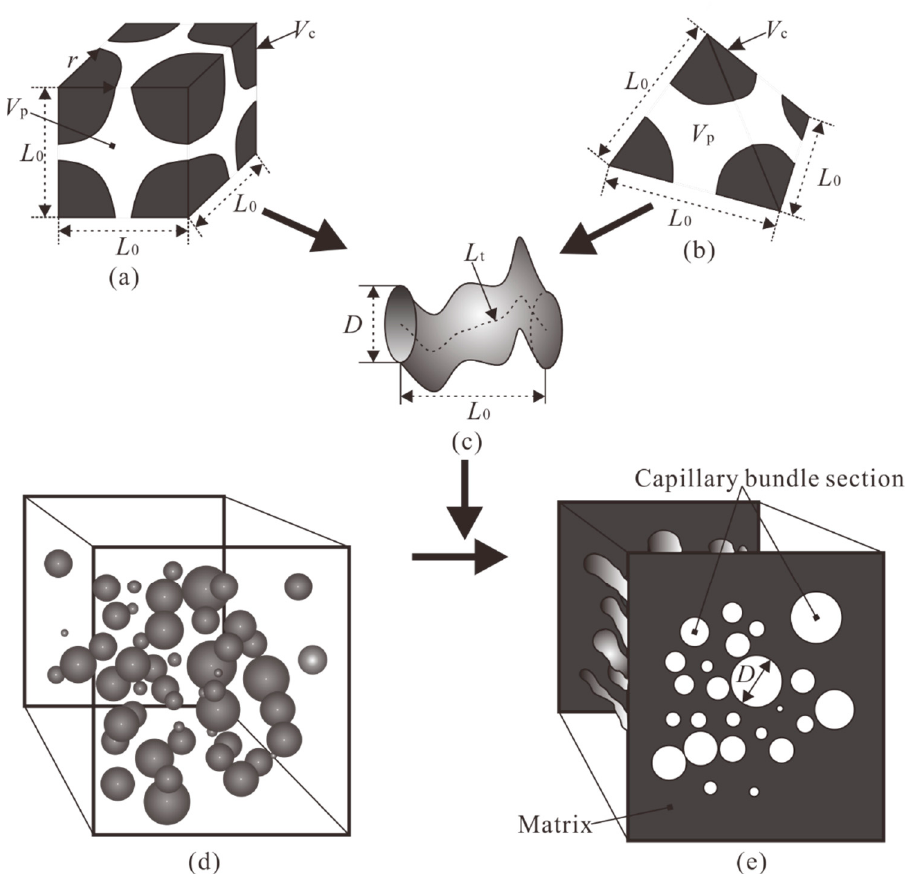
Figure 3. Schematic diagram of irregular pore space transformed into capillary bundle model. ( a ) conventional loose arrangement; ( b ) regular compact permutation; ( c ) capillary channel; ( d ) actual particle model; ( e ) transformed capillary model.